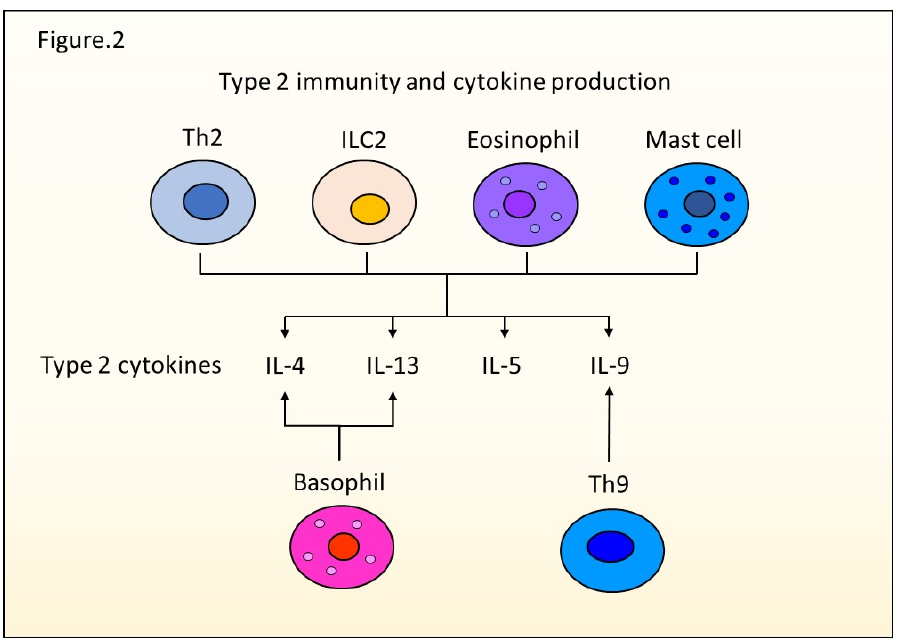
Figure 2. Type 2 immunity and cytokine production. Th2 cells, ILC2s, eosinophils, mast cells, basophils, and Th9 cells are type 2 immune cells producing IL-4, IL-5, IL-9, and IL-13.